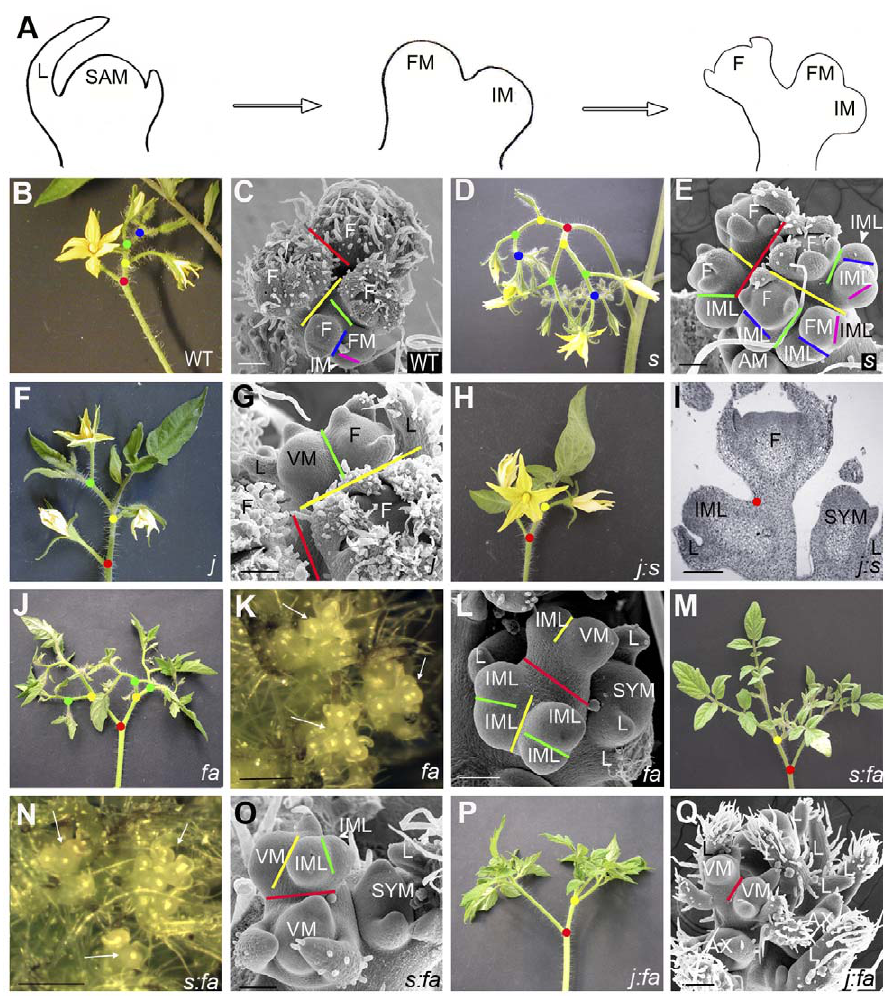
Figure 2. Inflorescence phenotype of tomato mutants. (A–C) Ailsa Craig WT; (D) and (E) s mutant; (F) and (G) j mutant; (H) and (I) j:s double mutant; (J–L) fa mutant; (M–O) s:fa double mutant; (P) and (Q) j:fa double mutant. In microscopic pictures, colour bars show the clefts that occurred sequentially when new meristems were initiated to build-up the inflorescence. Red: 1 st ; yellow: 2 nd ; green: 3 rd ; blue: 4 th ; purple: 5 th . Dots of same colours show the corresponding branching in macroscopic inflorescence pictures. Pictures K and N zoom in J and M, respectively, to show clumps of IMLs in the inflorescences (arrows). Genotype abbreviations: AC, Ailsa Craig WT; fa , falsiflora ; j , jointless ; s , compound inflorescence . Annotations: AX, axillary meristem; F, flower; FM, flower meristem; IM, inflorescence meristem; IML, IM-like; L, leaf; SAM, shoot apical meristem; SYM, sympodial meristem; VM, vegetative meristem. Bars=100 m m except in K and N where bars=1 mm.